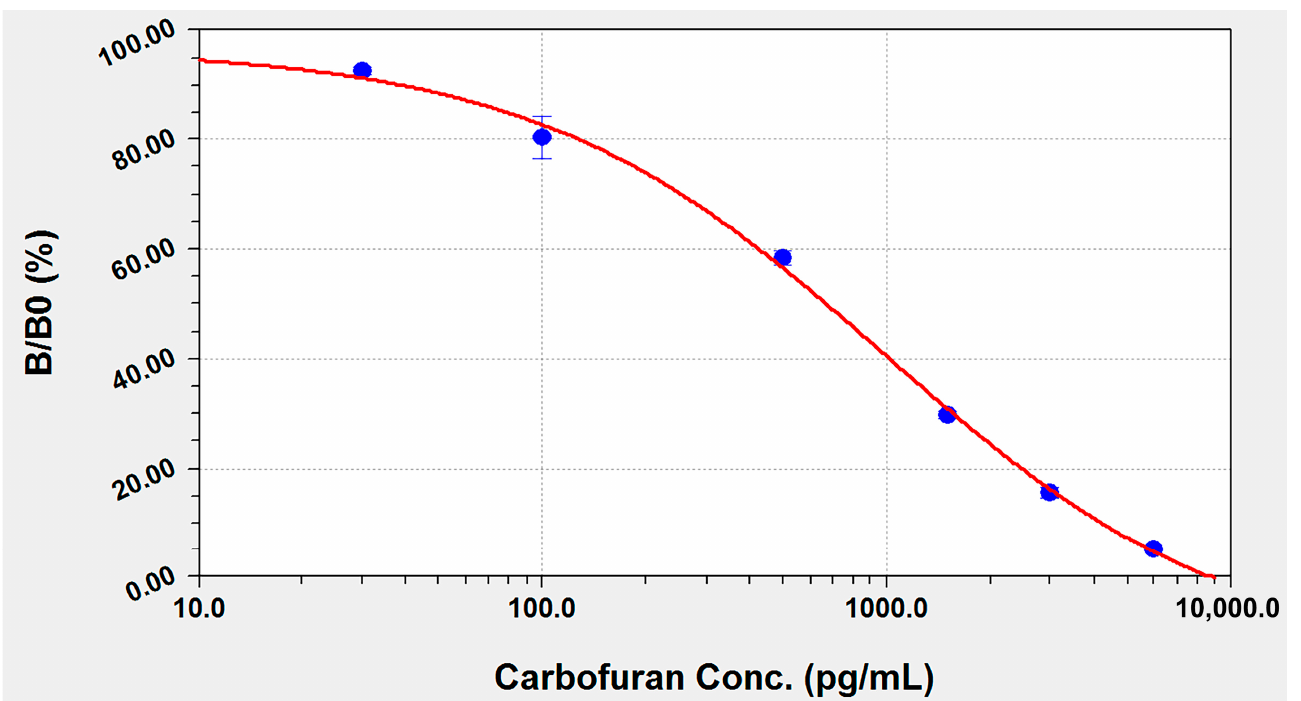
Figure 5. Standard curve for the determination of carbofuran by QD-LFIA; the abscissa is the logarithm of the carbofuran concentration (pg/mL) and the ordinate is the inhibition rate. Different concentrations of benfuracarb, carbosulfan, 3-hydroxy-carbofuran, metolcarb, carbaryl and aldicarb were detected to obtain standard curves, and the IC 50 and CR